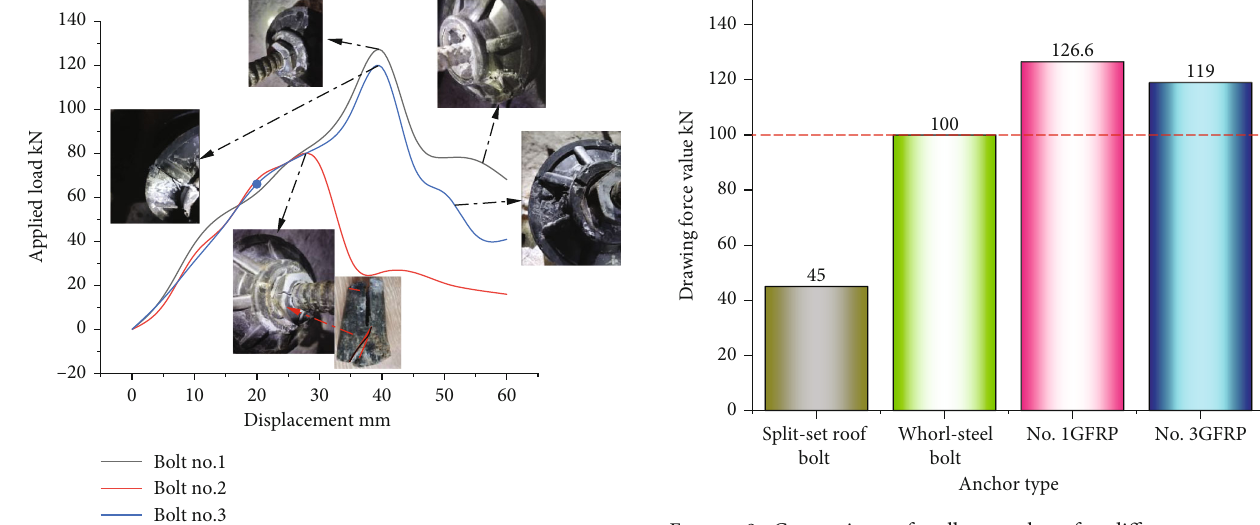
Figure 8: Anchor displacement-pulling force curve.